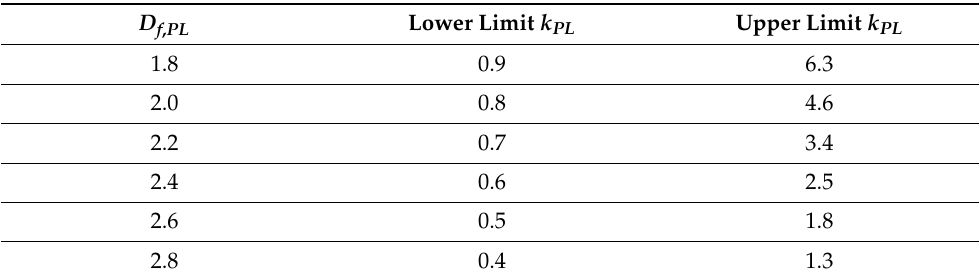
Table 5. Realized ranges of k PL for aggregates with different D f , PL